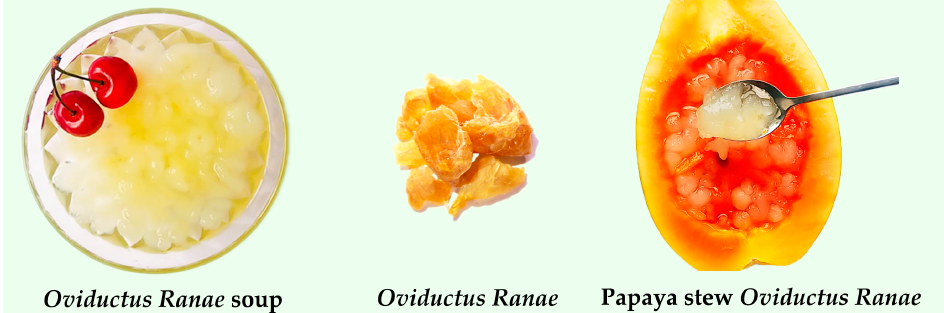
Figure 1. Oviductus Ranae sample and its typical edible methods, including Oviductus Ranae soup and Papaya stew Oviductus Ranae .